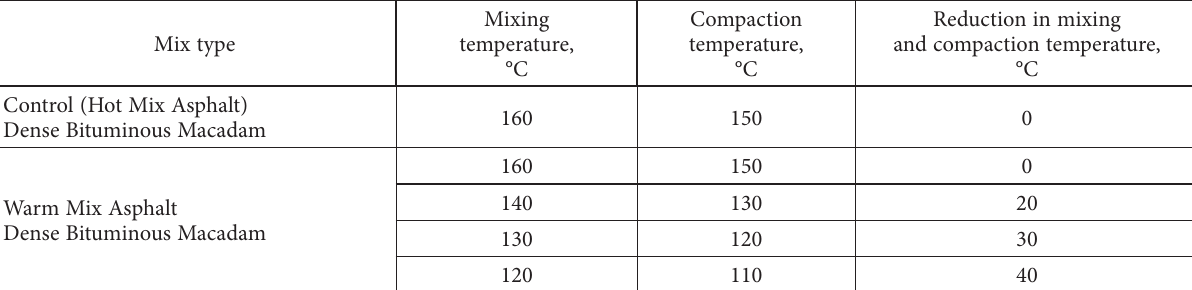
Table 4. Different mixing and compaction temperatures used in the study Mixing